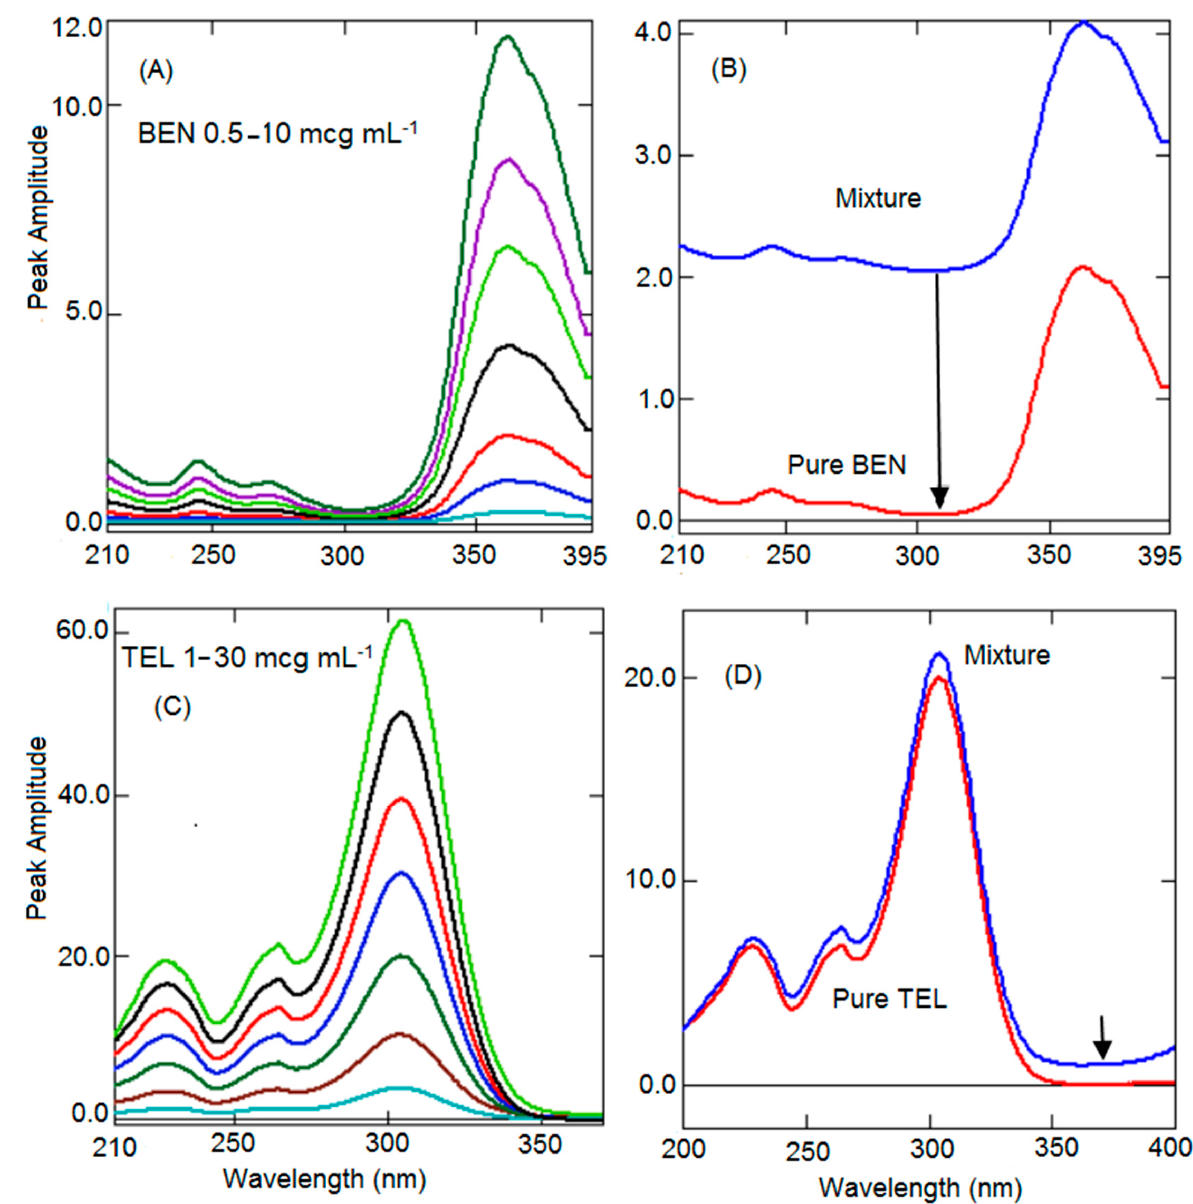
Figure 3. Ratio absorption spectra of BEN ( A ). Ratio absorption of BEN pure (Red) and mixture (Blue) ( B ). Ratio absorption spectra of TEL ( C ). Ratio absorption of TEL pure (Red) and mixture (Blue) ( D ). Arrow position indicates the wavelength at which constant was subtracted.